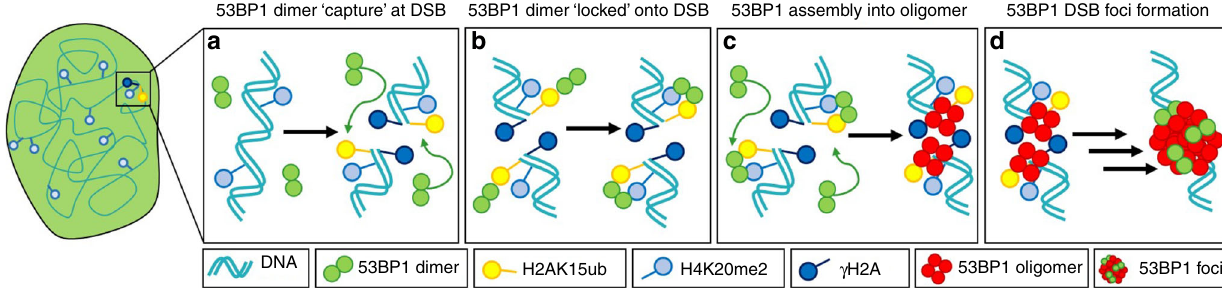
Fig. 6 Schematic of the ‘ capture ’ and ‘ lock ’ mechanism of 53BP1 foci formation. a – d FFS analysis of 53BP1 dynamics in live DIvA cells revealed that upon DSB induction H2AK15ub mediates ef fi cient 53BP1 dimer capture onto a DSB site ( a ), H4K20me2 serves a lock function for 53BP1 dimer retention at this nuclear location ( b ), and it is this cooperative interaction with H2AK15ub and H4K20me2, which initiates 53BP1 oligomerization ( c ) and 53BP1 foci formation ( d